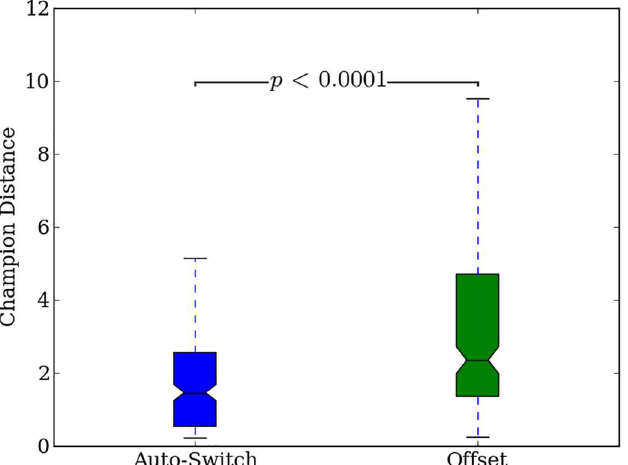
Fig 24. Final fitness for Offset-HybrID and Auto-Switch-HybrID on the quadruped robot transfer experiment. The distancetraveled by Offset-HybrID and Auto-Switch-HybrID run championsafter 3,000 generationsaveragedover all regularities of the quadrupedrobot transfer